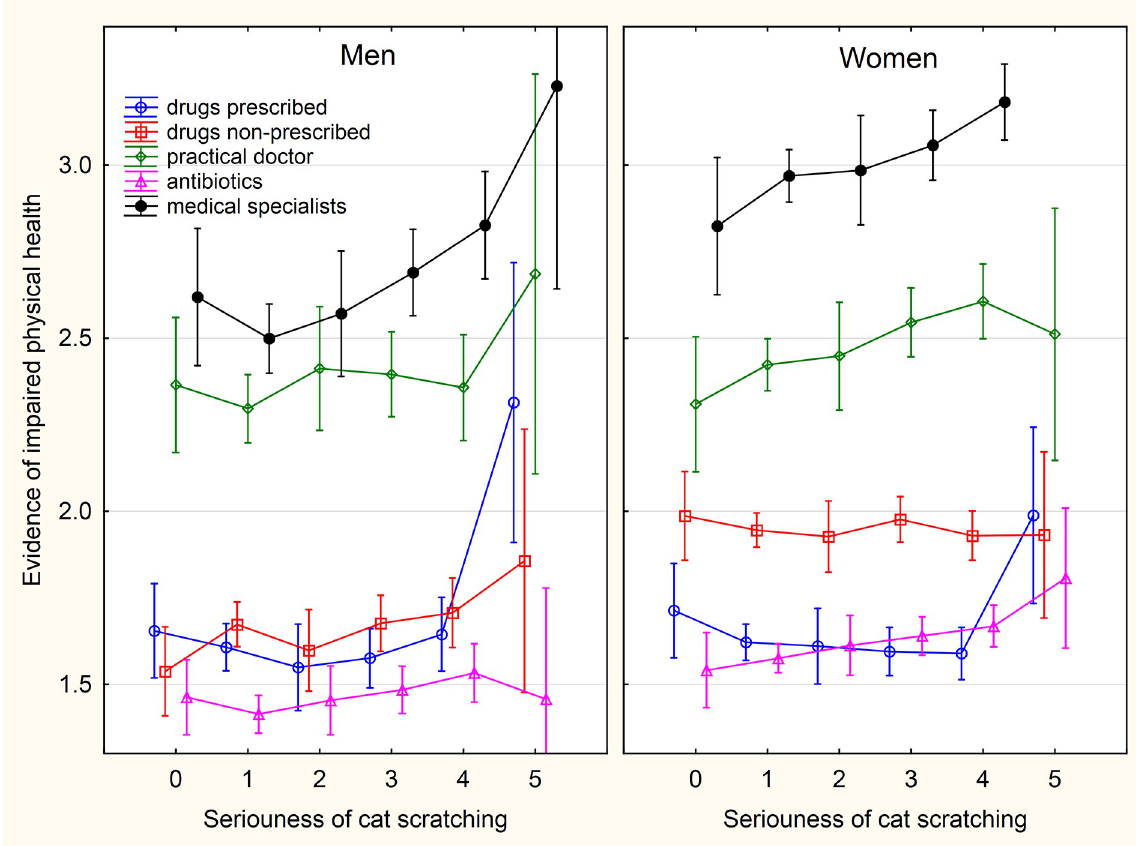
Fig 6. Association between intensity of sustained cat scratching and physical health related variables. The categories on x-axis describing the intensity of being injured by a pet are: 0- never, 1- only while playing, 2- only as a warning, 3- yes, minor injury (only skin cut), 4- yes, moderate injury (bleeding), 5- yes, serious injury, I had to seek medical